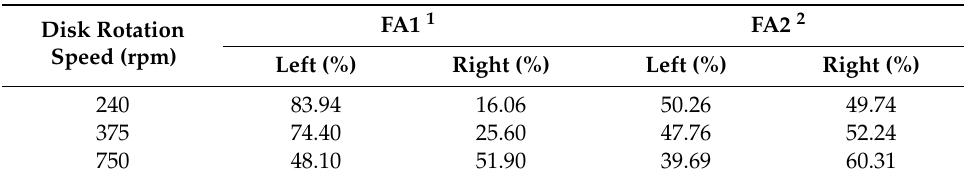
Table 1. Percentage of fertilizer applied to each side of the co ff ee plants for the two operating modes and the three spreading disk rotation speeds